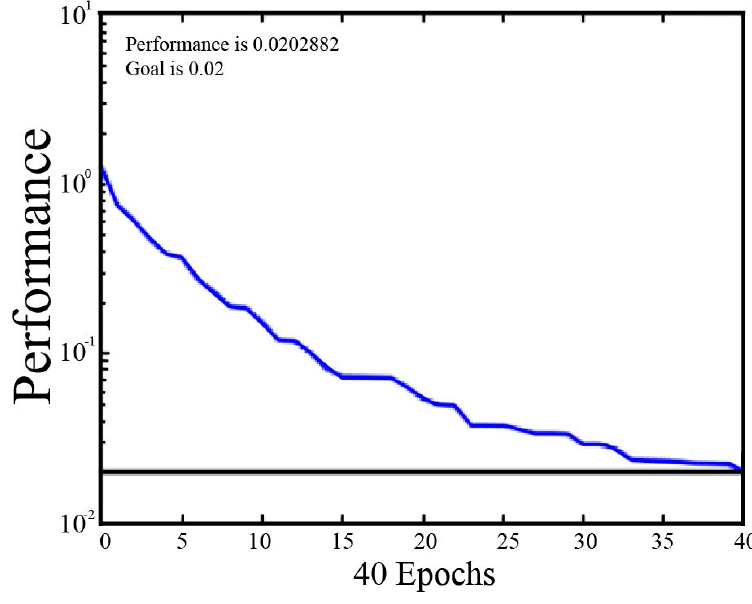
Figure 5. Diagram of the RBFNN iteration process result.